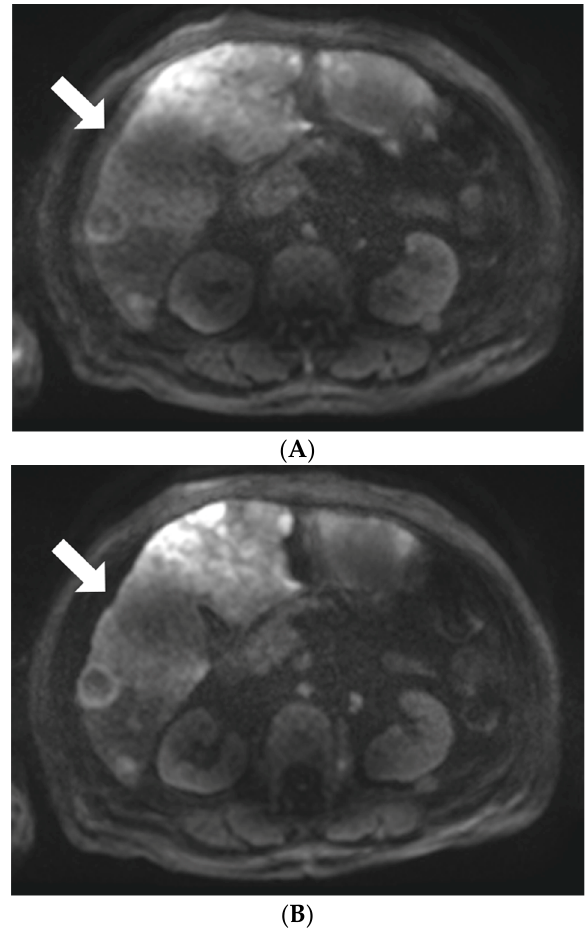
Figure 2. A 72-year-old woman with intrahepatic cholangiocarcinoma who underwent diffusion- weighted imaging (DWI). ( A ) Axial conventional c-DWI (b = 800 s/mm 2 ) and ( B ) axial motion-corrected (moco) DWI ((b = 800 s/mm 2 ). Margin sharpness of the right liver lobe (arrows) is superior in moco-DWI ( B ) to that in c-DWI ( A ).